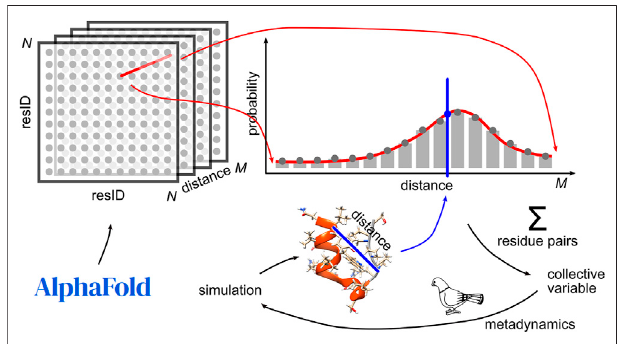
FIGURE 1 | Schematic representation of AlphaFold-based CV (AlphaFold logo - credit to